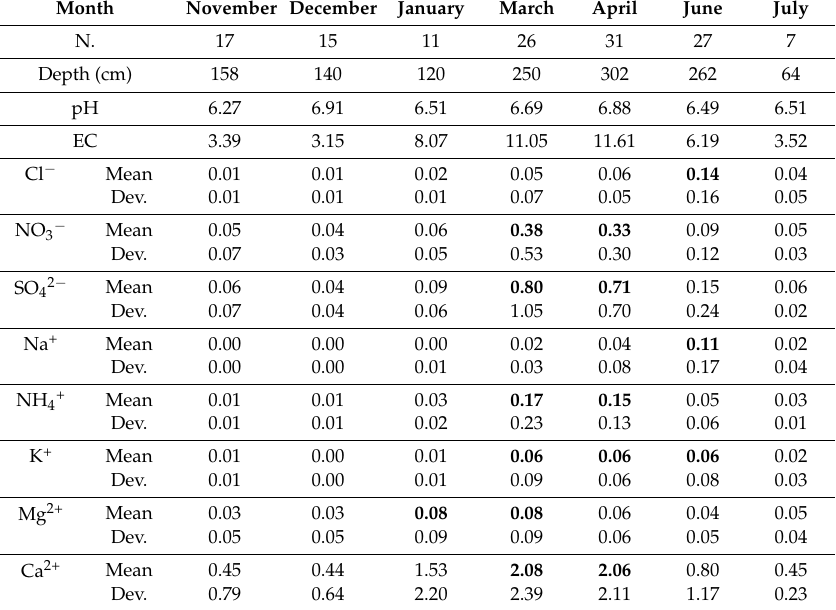
Table 1. Major ion concentrations (mg/L) of the snowpack samples from Baishui Glacier No. 1 in Mt. Yulong (bolded values are high ionic